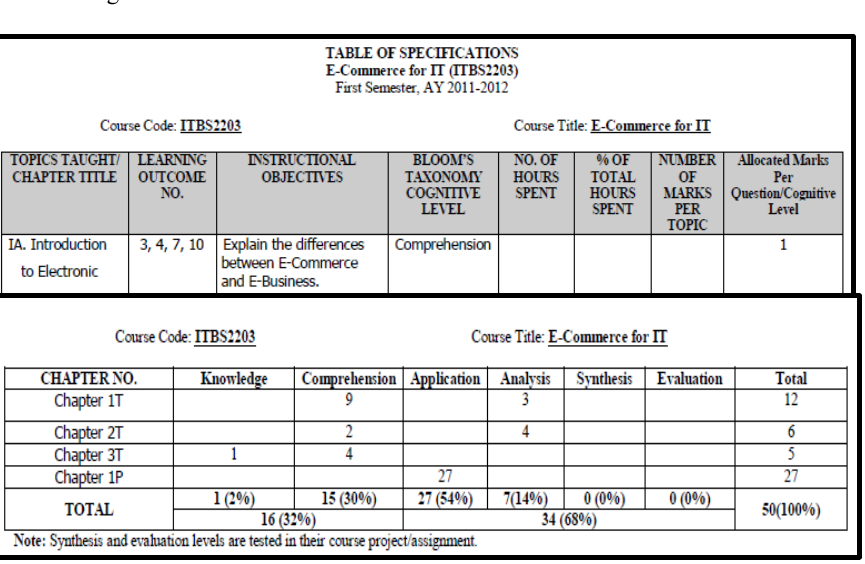
Fig. 3. Paper-and-Pencil Prototype of the Test